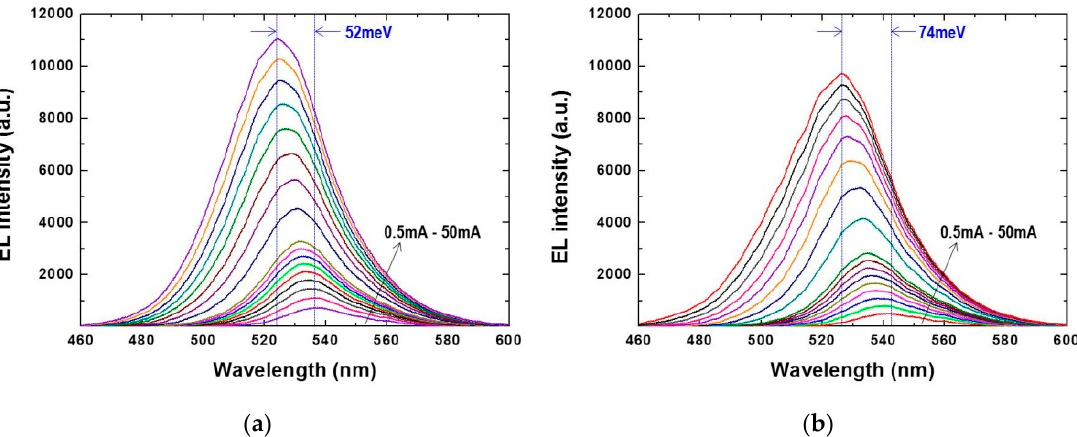
Figure 4. Electroluminescence (EL) spectrum dependence on driving current of ( a ) LED A and ( b ) LED B.